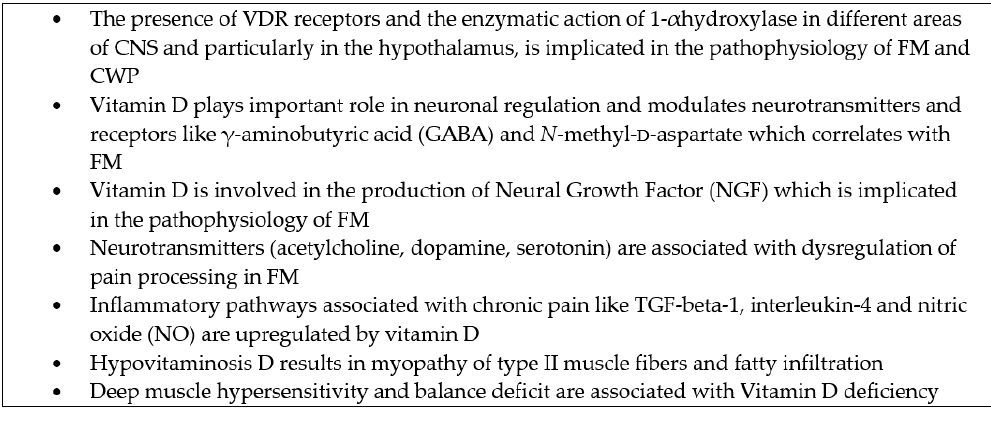
Figure 1. Hypothetical pathophysiological mechanisms of vitamin D and FM interplay. Abbreviations: VDR: Vitamin D receptor; FM: Fibromyalgia; CNS: Central nervous system; CWP: Chronic widespread pain.